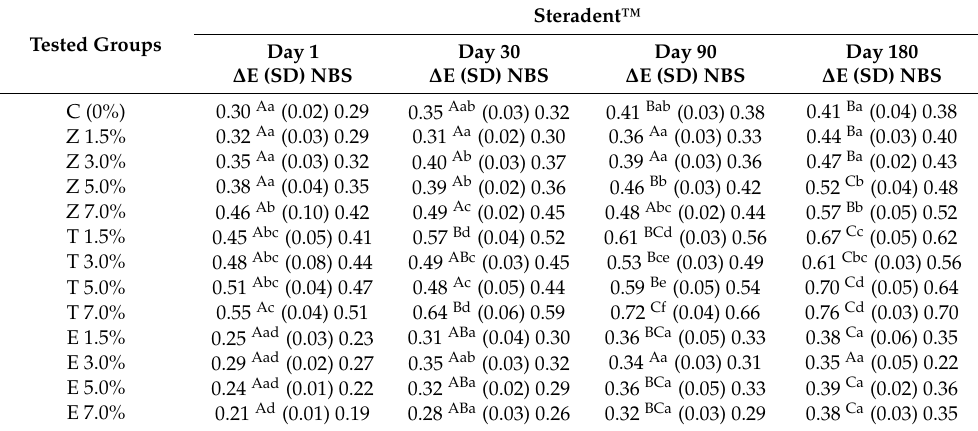
Table 4. Results of the two-way RM-ANOVA with descriptive statistics of ( ∆ E) and National Bureau of Standards (NBS) unit at four different time intervals for each group after immersion in Steradent™.